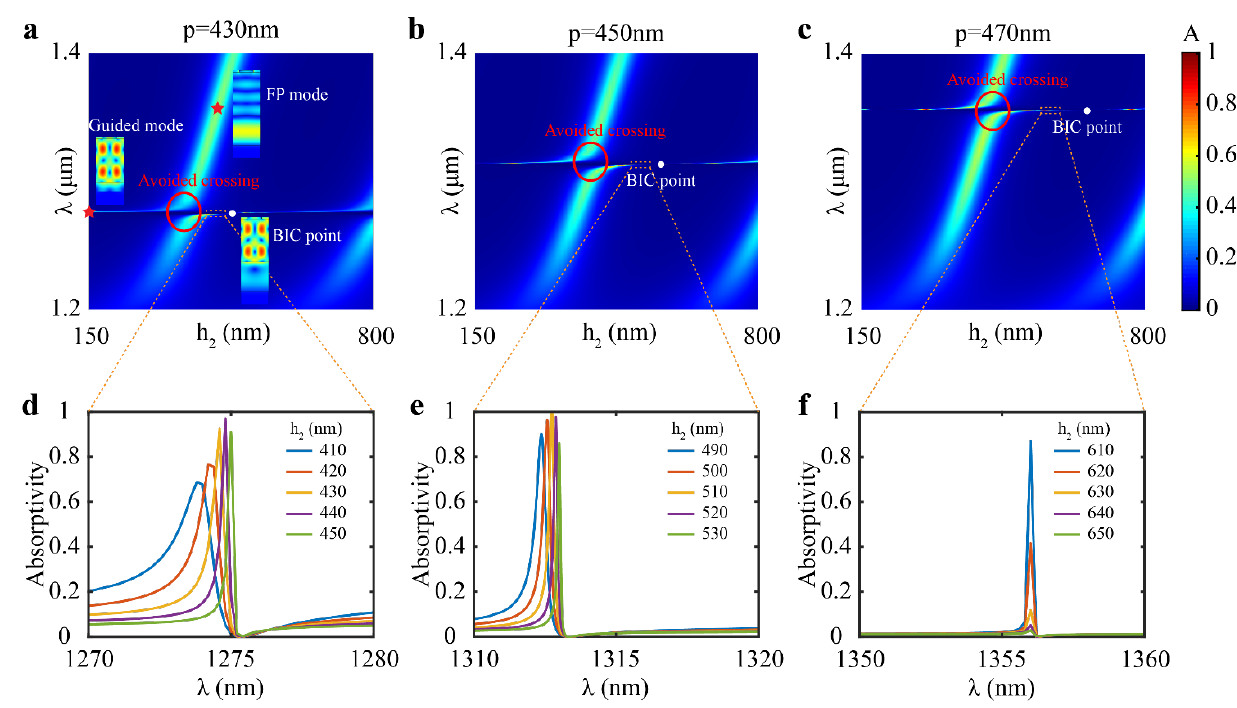
Figure 2. Simulation results of absorptivity. ( a – c ) Dispersion relation of absorptivity versus wave- length and the SiO 2 layer thickness for the period p values of 430 nm, 450 nm, and 470 nm, respectively. Insets show electric field distributions in ( a ) corresponding to the guided mode and the FP mode (the red stars) and the BIC point (the white point). Red circled area represents the avoided crossing. ( d – f ) The absorptivity curves for different SiO 2 layer thicknesses h 2 (with the interval of 10 nm), corresponding to the indicated orange dashed area of ( a – c ), respectively.